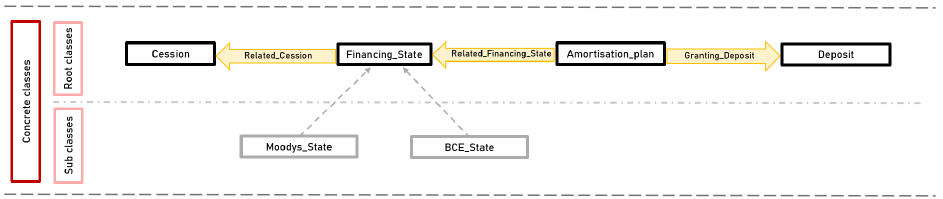
Figure 6. Concrete Layer for the running example extended with Look-Up